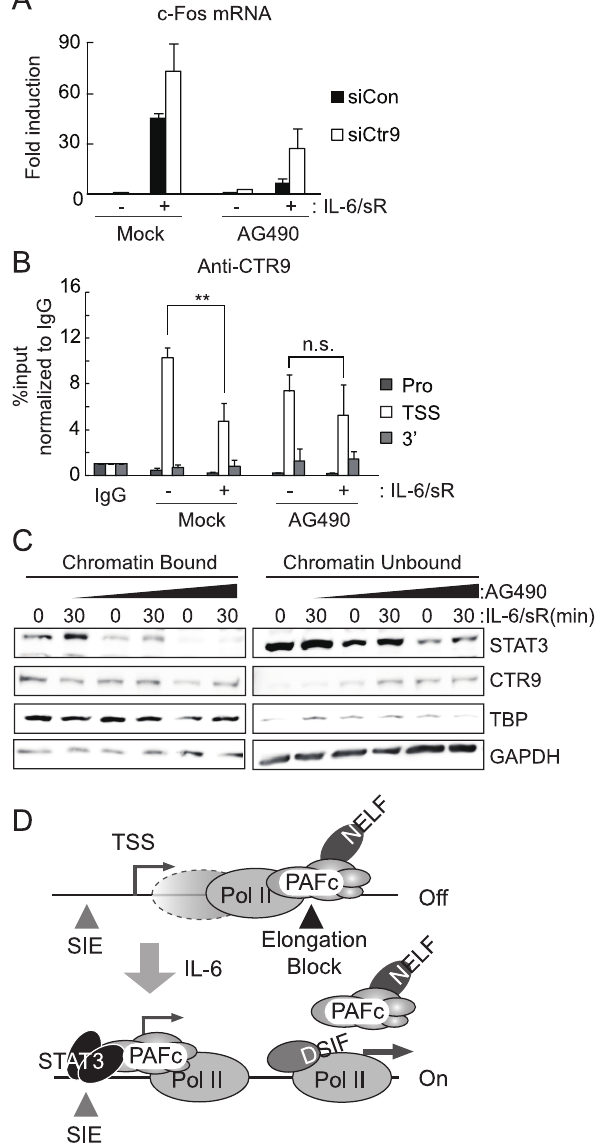
Figure 5. Chromatin association of CTR9 requires kinase activity inhibited by AG490. A , Cells were transfected with control siRNA or CTR9 siRNA for 48 hrs and treated with DMSO (mock) or AG490 (100 uM) for 4 hrs prior to IL-6 plus IL-6sR (20 ng/ml each) stimulation for 30 min. The c-Fos mRNA induction level was measured by RT-qPCR. B , Cells were treated as in A and a ChIP assay was performed with an anti-CTR9 antibody. Bound DNAs were analyzed by quantitative PCR using primers specific to c-Fos genomic loci. C , Cells were treated with DMSO (mock), 100 uM or 200 uM of AG490 for 12 hrs prior to IL-6 plus IL-6sR (20 ng/ml each) stimulation for 30 min. Cells were fractionated into chromatin -unbound and -bound fractions and blotted with anti-CTR9, anti-STAT3, anti-TBP, and anti-GAPDH antibod- ies. D , Negative function of PAFc in IL-6-responsive gene regulation. At TSS of IEG loci in basal condition, PAFc is associated with NELF. Upon IL- 6 stimulation, PAFc along with NELF dissociates from the elongation block to allow transcriptional elongation to occur. SIE: Serum Inducible Element (STAT3 binding site). n.s.=not significant, **p , 0.01 by Student’s t test. Error bars represents SD